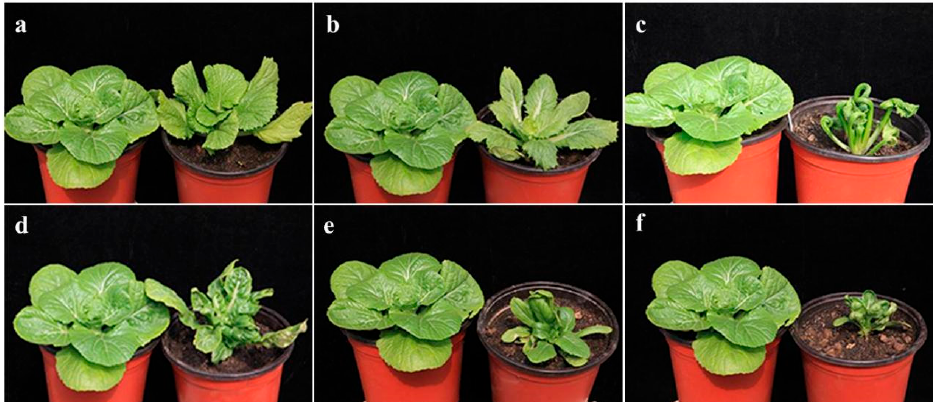
Figure 7. Six leaf shape mutants. ( a , b ) The wild-type ‘FT’ plant (left) and leaf margin mutants (right); ( c ) the wild-type ‘FT’ plant (left) and no mesophyll mutant (right); ( d – f ) the wild-type ‘FT’ plant (left) and crimple leaf mutants (right). The leafy head of wild-type ‘FT’ was ovoid, and the heading leaves were folded and shriveled. A total of 85 leafy head mutants were verified in the M 2 generation, and the mutation frequency was 2.27%. Forty-six non-heading mutants were identified (Figure 8). Twenty vertical leafy head mutants were observed at a frequency of 0.54%.